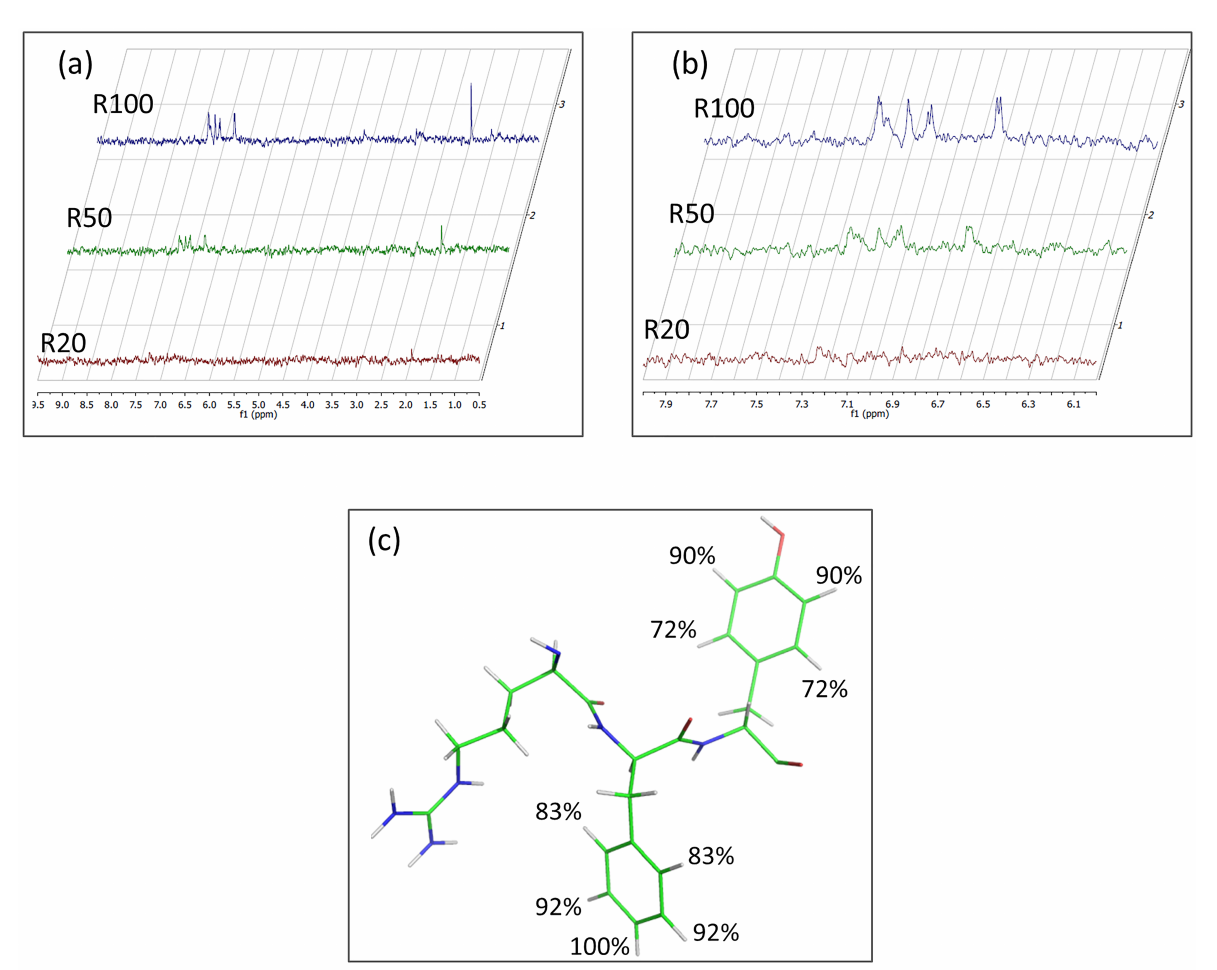
Figure 4. ( a ) STD spectra acquired at 10 µM of MKK7-KD and SCRB/MKK7-KD ratio values in the range 5 ÷ 100; ( b ) Zoom-in of the aromatic region; ( c ) Molecular model of SCRB reporting the group epitope mapping (GEM) at